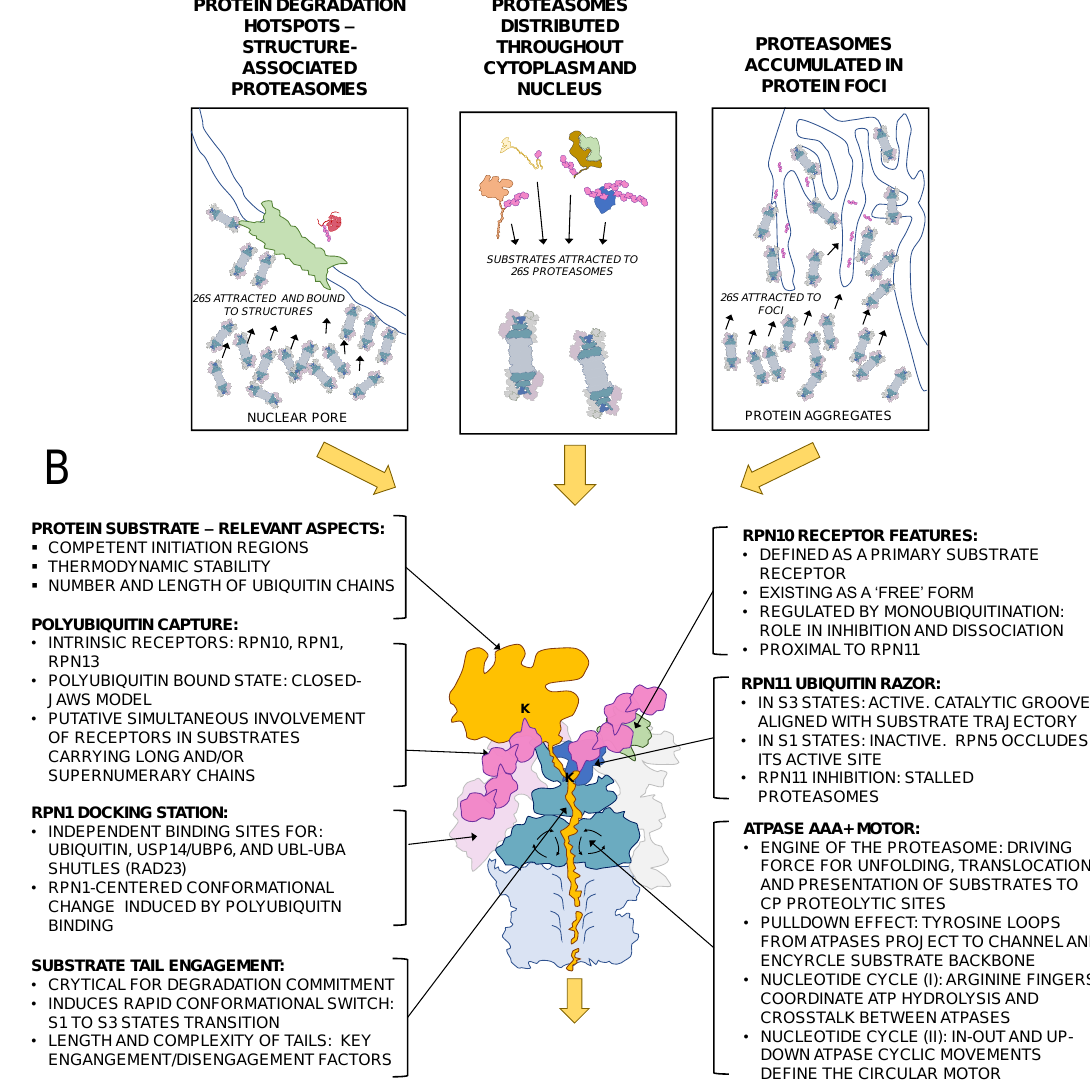
Figure 1. Schematic representation of the main aspects in 26S proteasome mechanism. ( A ) Di ff erent possible proteasome environments inside cells are presented, focusing on the works commented in the text. ( B ) Relevant points in the mechanism of protein degradation by the 26S